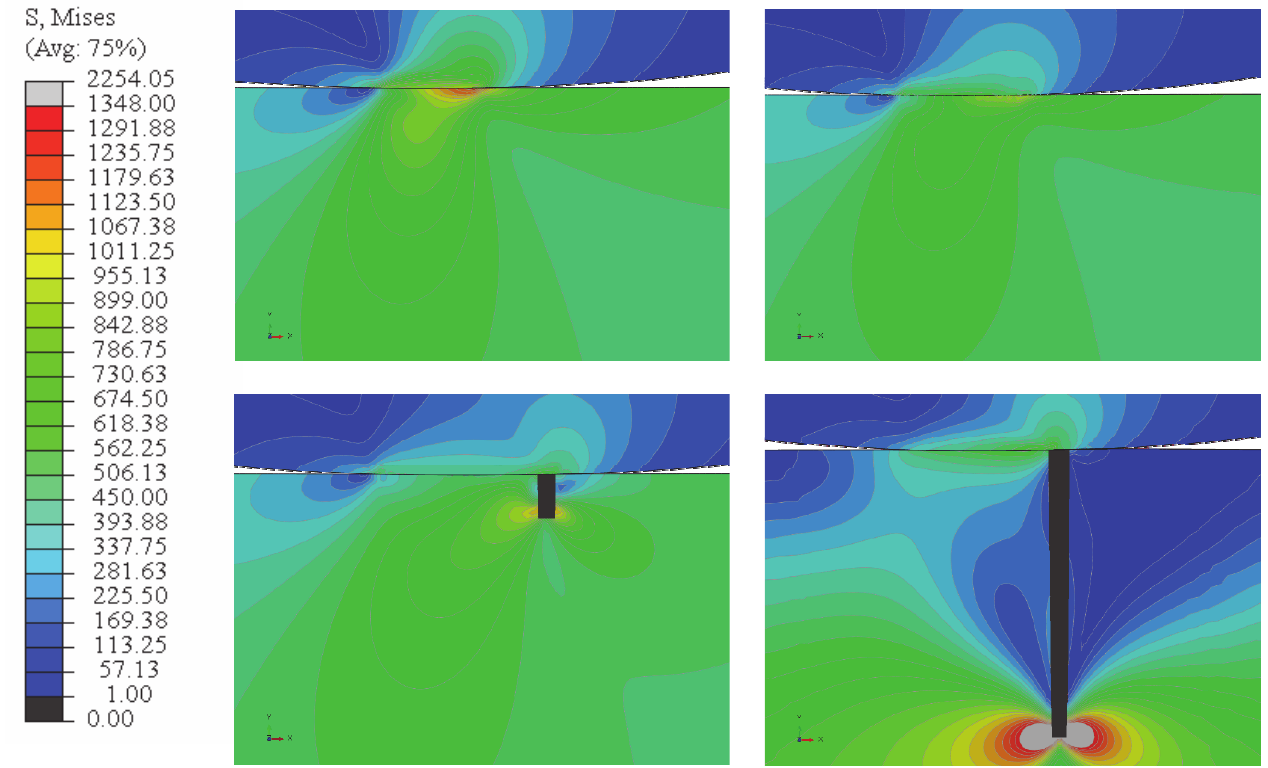
Figure 7: Evolution of the VM stress field at different stages. Top left: Cycle 1; top right: 10,000 cycles; bottom left 20,000 cycles; bottom right 49,300